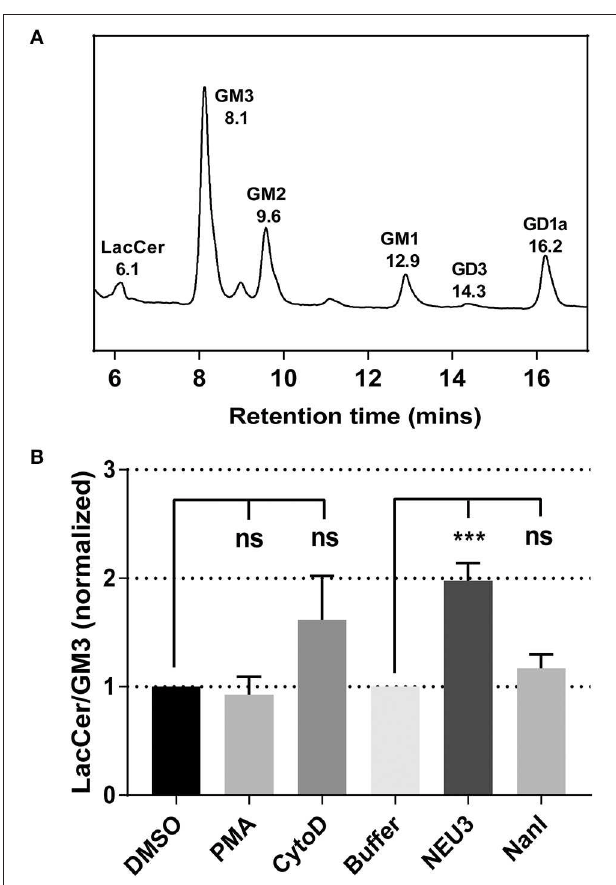
FIGURE 1 | Analysis of the change of cell membrane GSLs. GSLs were extracted from treated or control cells and analyzed by LC-MS. (A) Glycolipids extracted from Jurkat cells were digested with endoglycoceramidase, labeled and resolved by LC-MS-FLD. The major glycolipids observed were LacCer, GM3, GM2, GM1, and GD1a. (B) LC-MS-FLD analysis was performed on four replicate samples ( N = 4) for Jurkat cells treated as indicated. The ratio of LacCer to GM3 was calculated using the peak areas for each condition and normalized to the respective control. Data were compared to the indicated control using a student t -test to determine p -values; *** p ≤ 0.005; ns, not